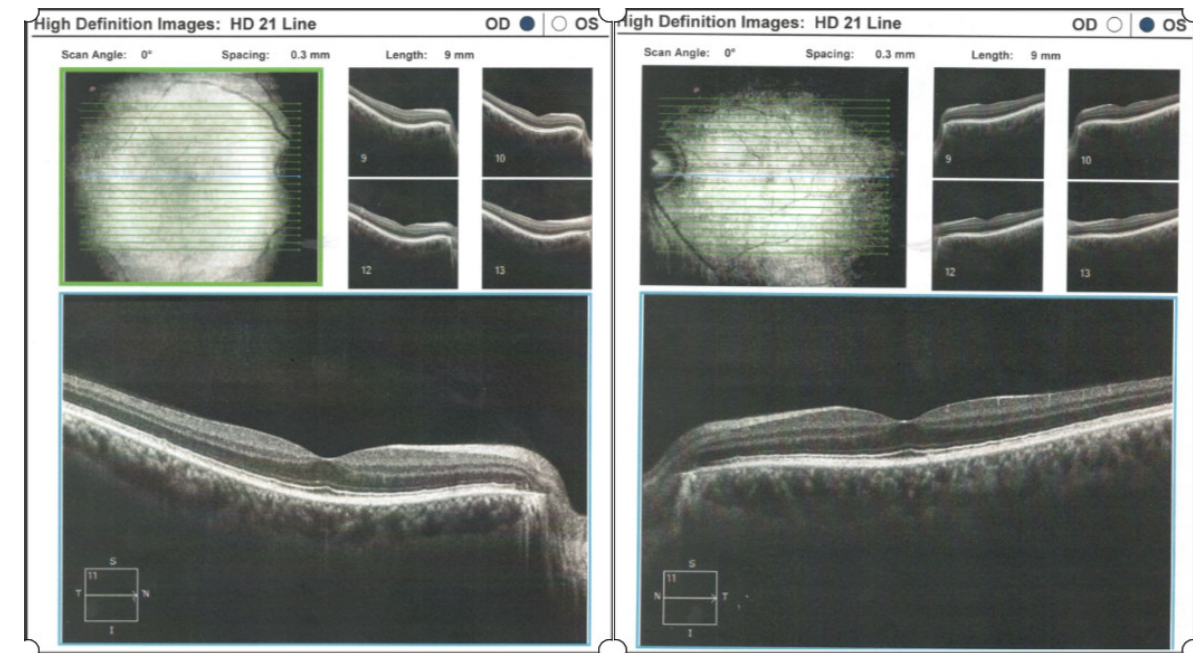
Figure 4. Optical coherence tomography.